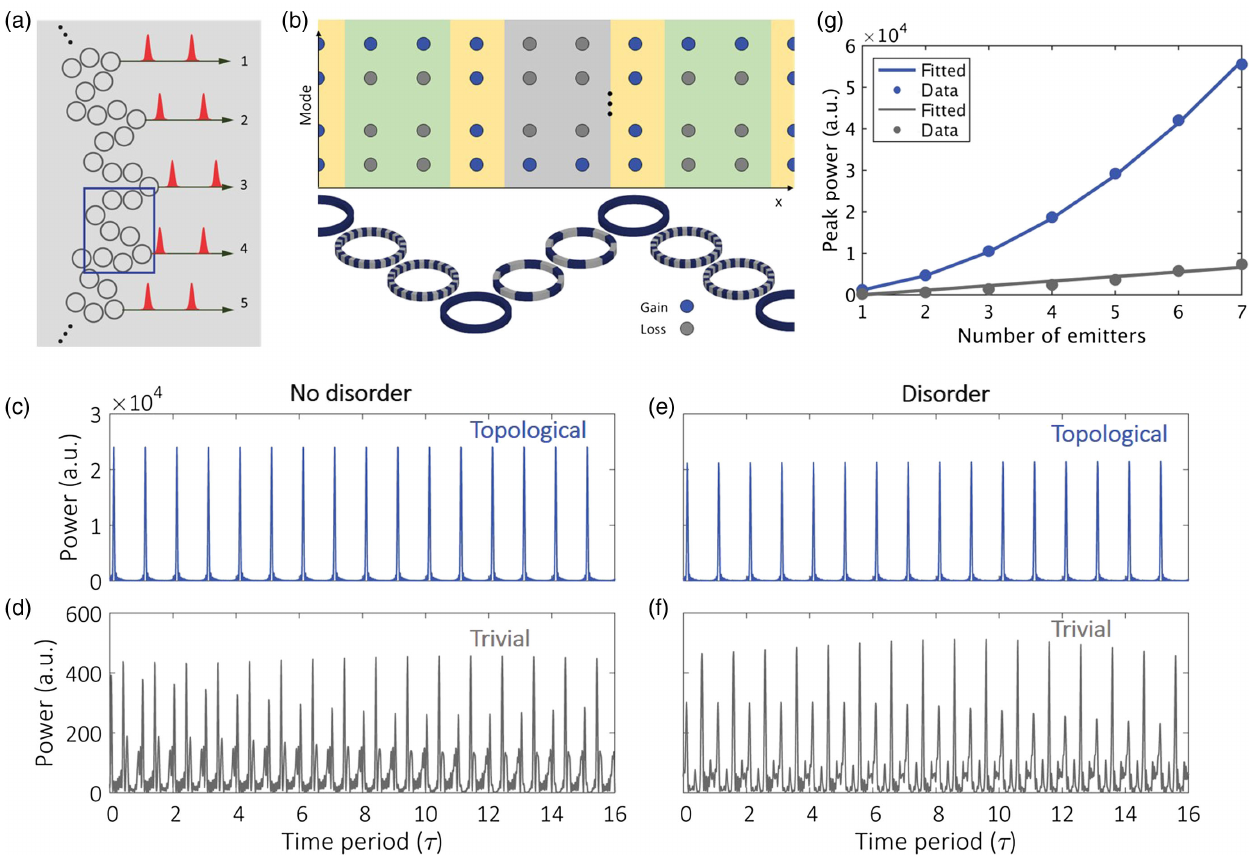
FIG. 5. Topological mode-locked laser array. (a) Scheme showing a laser array of n ¼ 5 modules [each of which is described by Fig. 1(a)]. The side resonators in the laser array configuration connect different chains of ring resonators. The lower panel shows an enlarged view of the blue box in (a). The laser light is extracted through output couplers. (b) The gain profile in synthetic dimensions. The ring resonators correspond to the ones within the blue box in (a). (c),(e) The topological laser array generates a train of mode-locked pulses (c) which are emitted from the rings with homogenous gain [top or bottom rings in (b)], and remain clean mode-locked pulses even in the presence of considerable on-site disorder with W ¼ 0 . 3 (which introduces frequency mismatch among the resonators) (e). (d),(f) The trivial laser array emits fluctuating pulses with much less output power (in arbitrary units, arb. units) even in the absence (d) and presence (f) of disorder. (g) Peak power scales with the number of emitters quadratically for topological laser (blue) and linearly for trivial laser (gray). The simulation parameters we used are the same as those in Fig. 1(a). The time axis is in units of τ ¼ 2 π = Ω . In panels (c) – (f) the laser output power is calculated from the sum of the electric fields of side rings in the laser